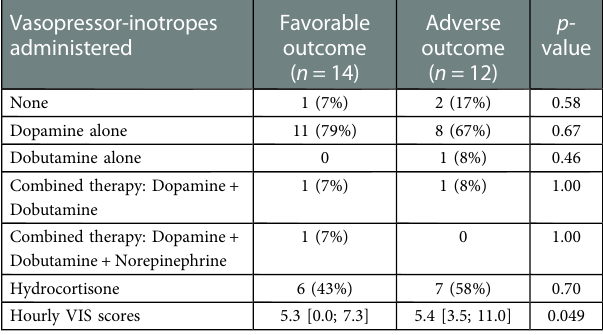
TABLE 2 Vasoactive drugs administered in the study population.